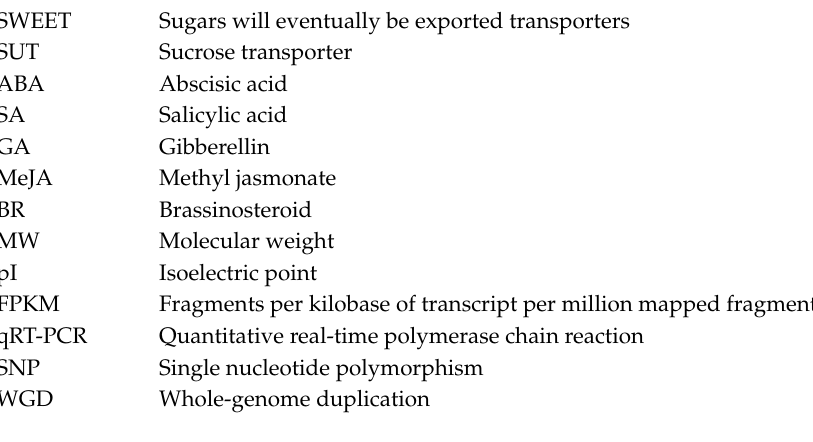
Table S1. Sequences of qRT-PCR primers of the selected GhSWEET genes and the GhHis3 internal reference gene. Table S2. Coding sequences of G. hirsutum SWEET genes. Table S3. Details regarding G. raimondii and G. arboreum SWEET genes. Table S4. Analysis of cis -acting regulatory elements in the promoters of putative GhSWEET genes responsive to environmental stresses and phytohormones. Table S5. Fst values of the SNPs in GhSWEET genes between wild and cultivated upland cotton lines. Figure S1. Distribution of orthologous pairs of SWEET genes between the G. hirsutum Dt subgenome and G. raimondii D genome (A) and between the G. hirsutum At subgenome and G. arboreum A genome (B). Different colored lines represent SWEET genes in four clades based on phylogenetic